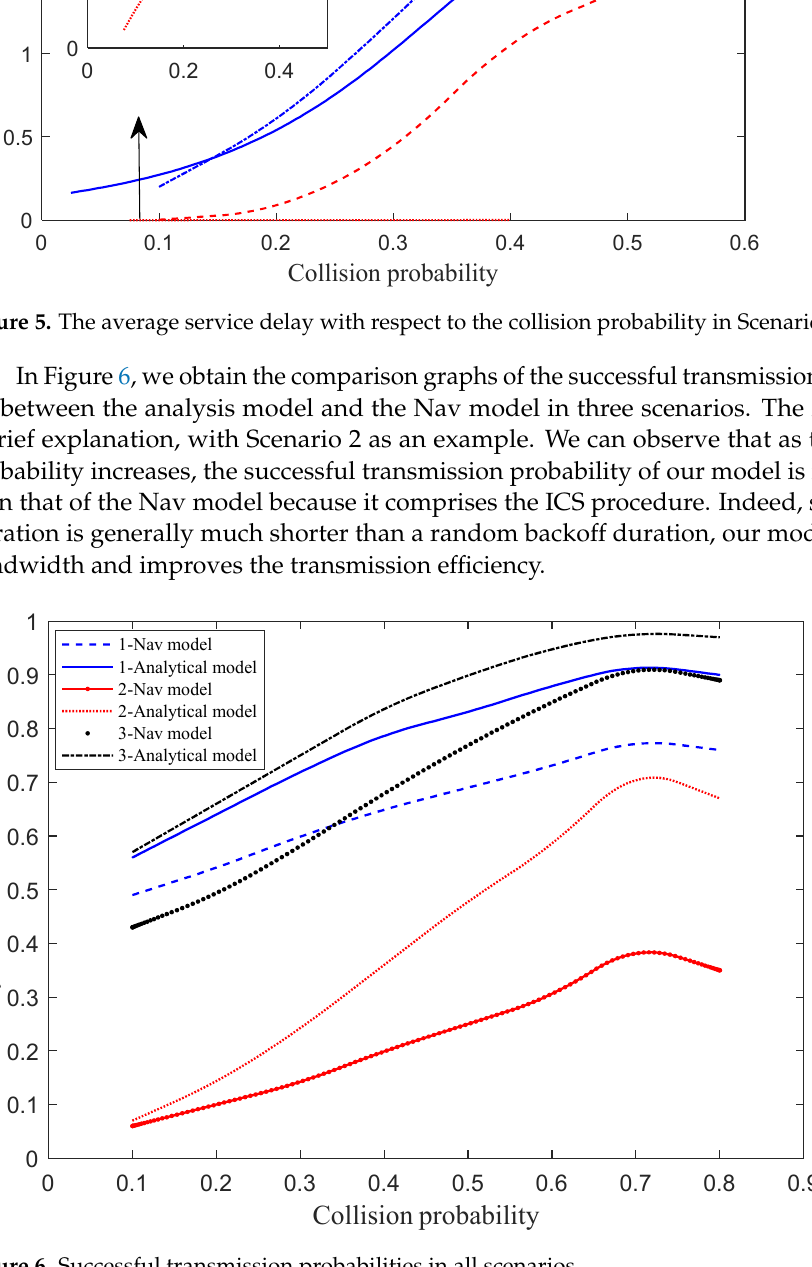
Figure 6. Successful transmission probabilities in all scenarios.